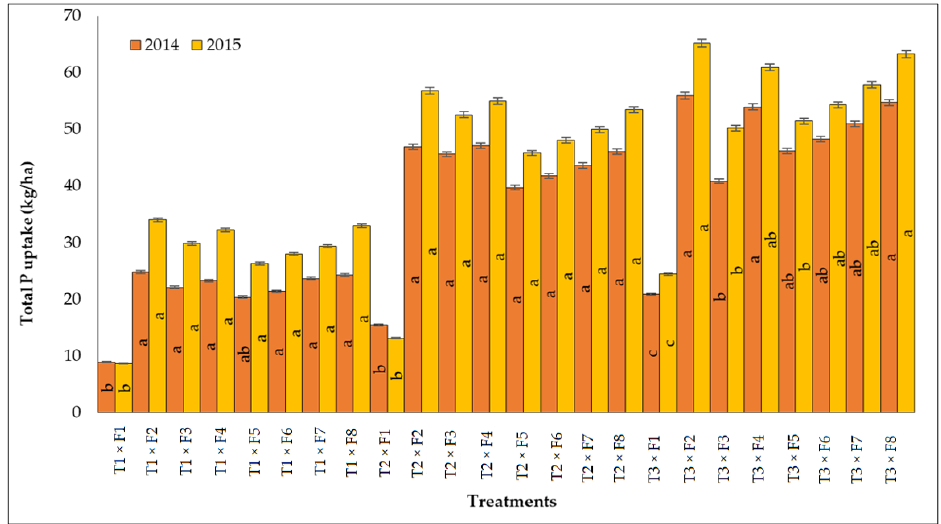
Figure 2. The combined effect of crop establishment methods and integrated nutrient management influence the total P uptake by rice in both years. Treatment details are in Table 1; Within each treatment combination, bars followed by the same lower-case letter(s) indicate significant differences at 5% level of probability. SE± in each treatment combination was calculated from three replications.